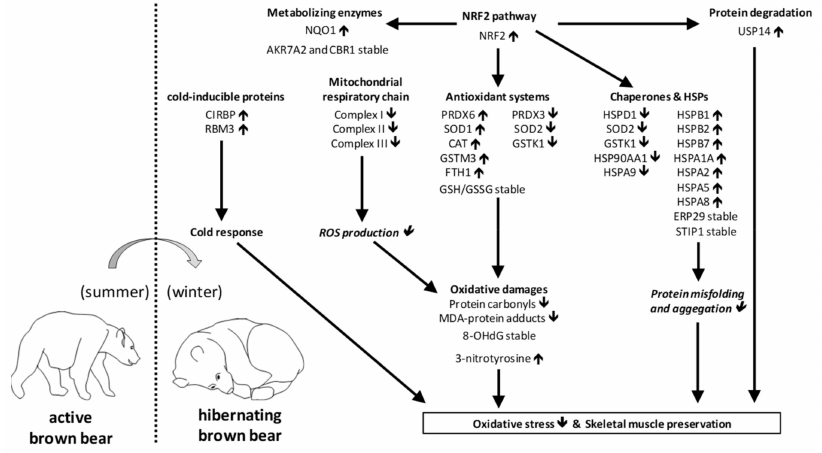
Figure 6. Proposed mechanisms based on reduced oxidative stress promoting skeletal muscle preservation in hibernating versus summer-active brown bears. In italic are shown features that were not directly